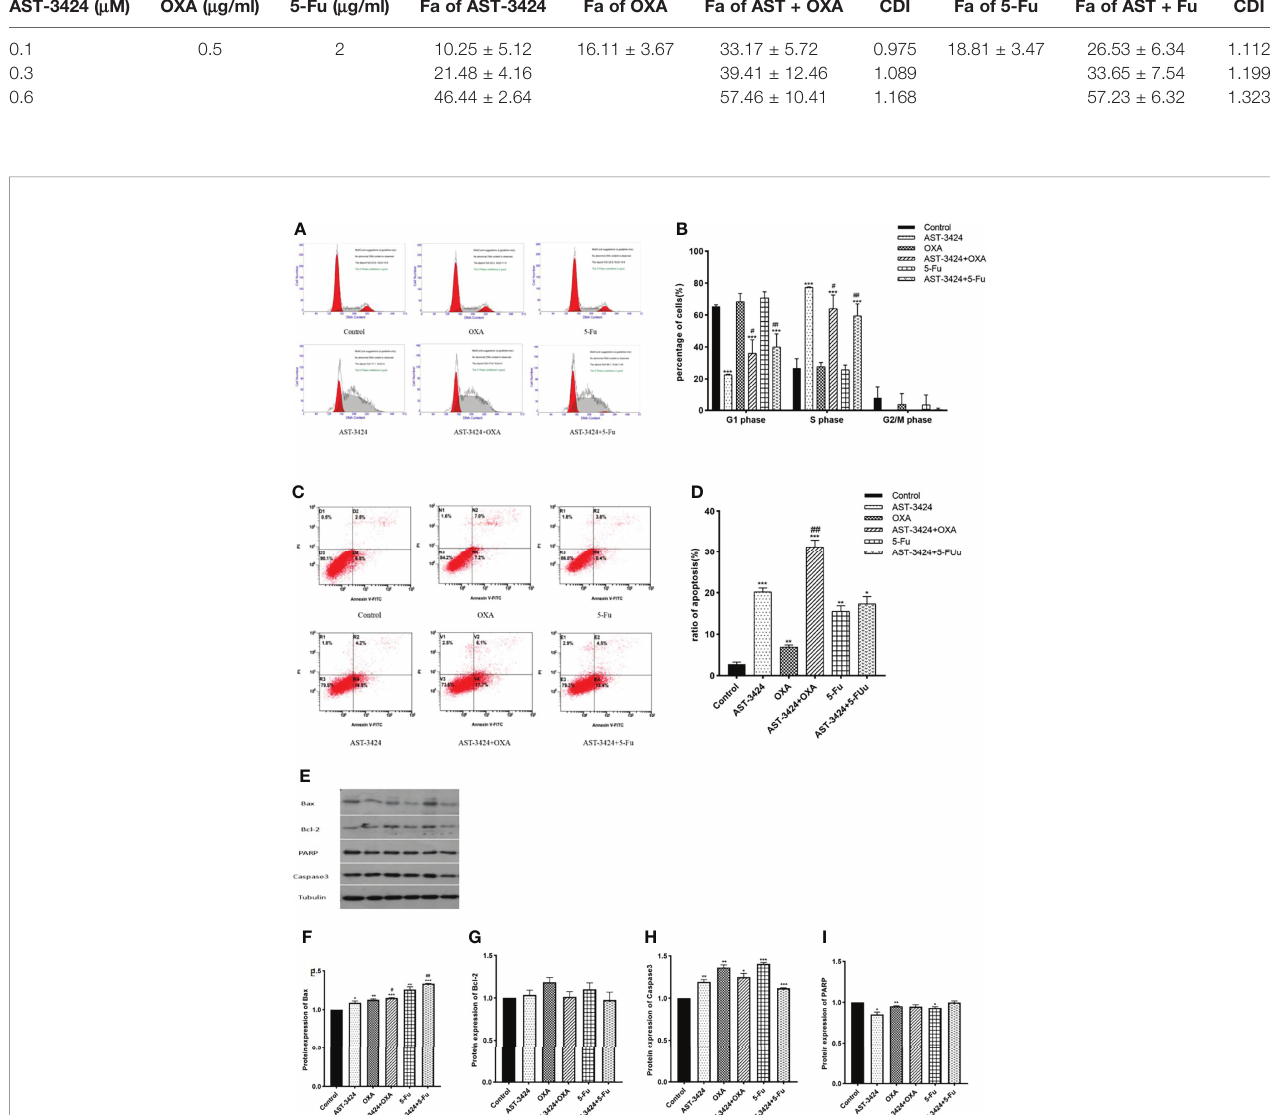
TABLE 2 | Fraction affected level (Fa) of AST-3424, OXA, and 5-Fu alone or in combination and the CDI values of the combination in PLC/PRF/5 cells. AST-3424 ( m M)